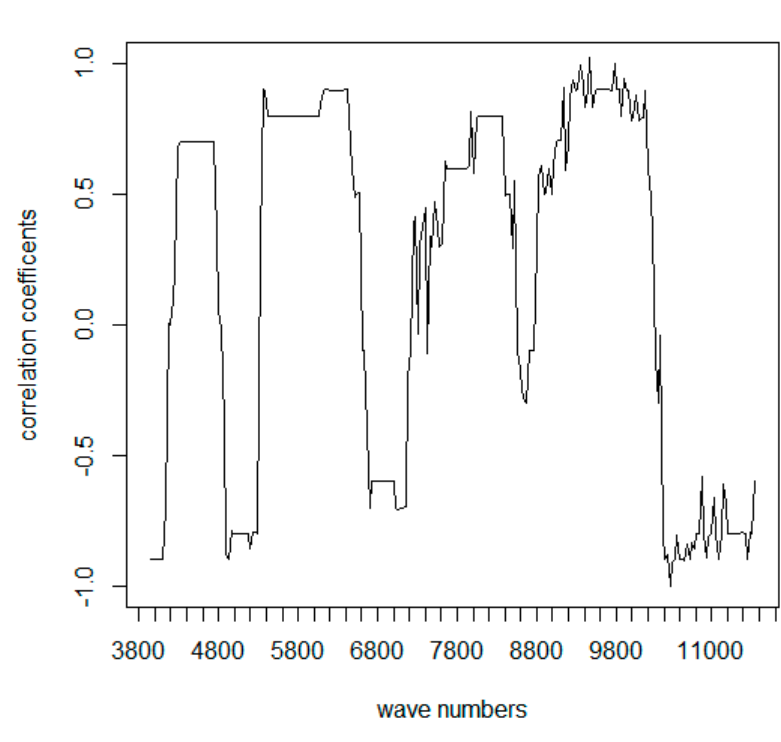
Figure 5. Correlogram: correlation coefficients between FT-NIR spectroscopic data and the sensory data “preference” of “Victoria” grape.